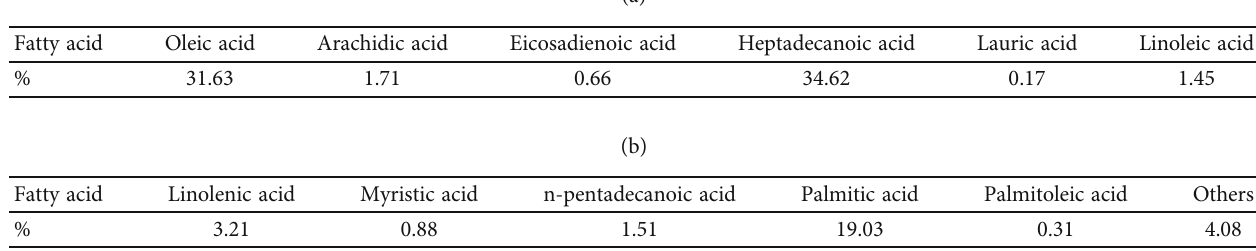
Table 1: Chemical composition of oil.